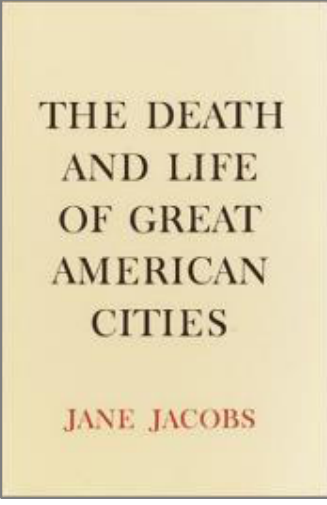
Figure 11 The Death and Life of Great American Cities (Jacobs, J., 1961)